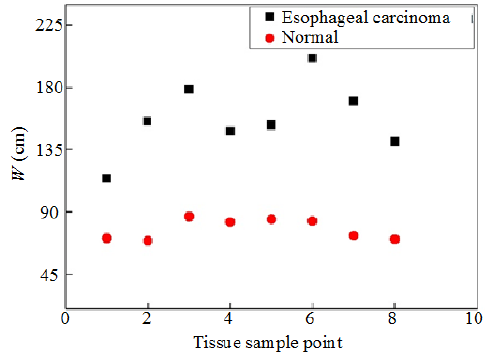
Fig. 5 Peak spectrum HHW distribution diagram of the Raman spectrum of normal and carcinoma tissues in the range of 1100 cm ‒ 1 ‒ 1400 cm ‒ 1 .